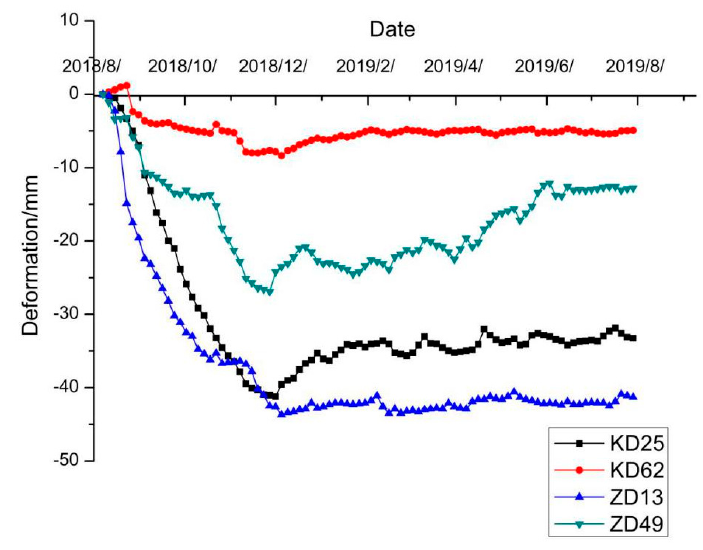
Figure 6. Surface deformation duration curve of each monitoring point.